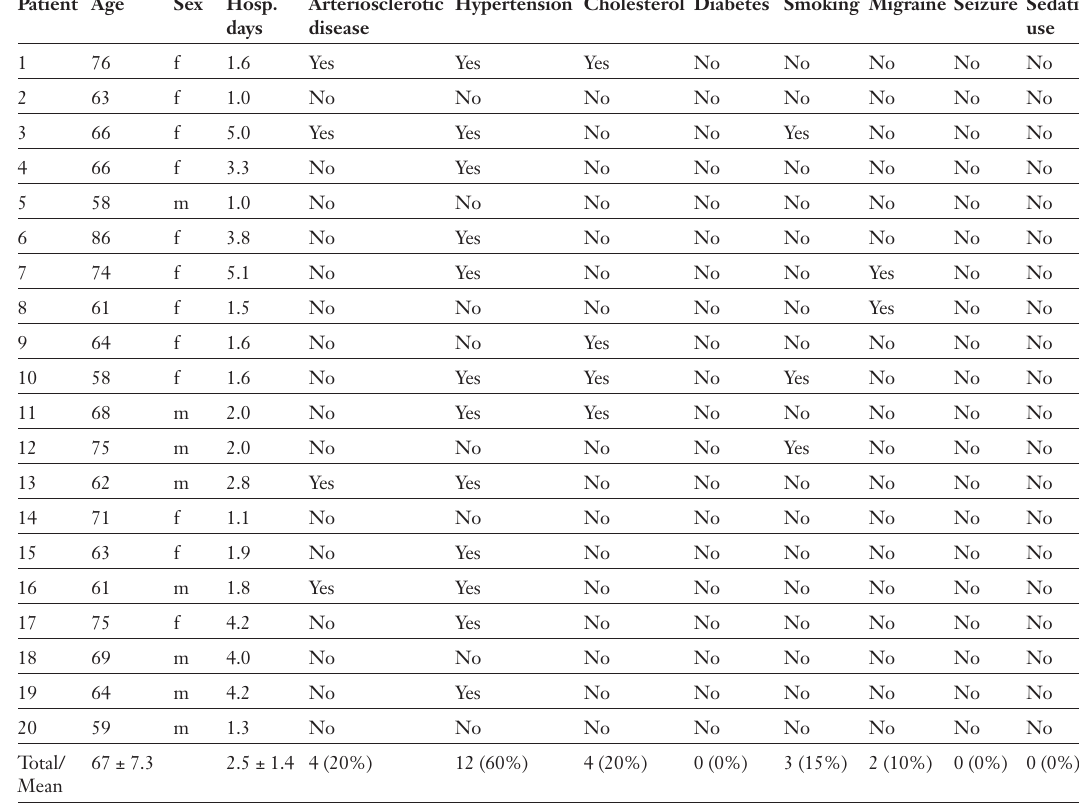
Patients’ characteris- tics and risk